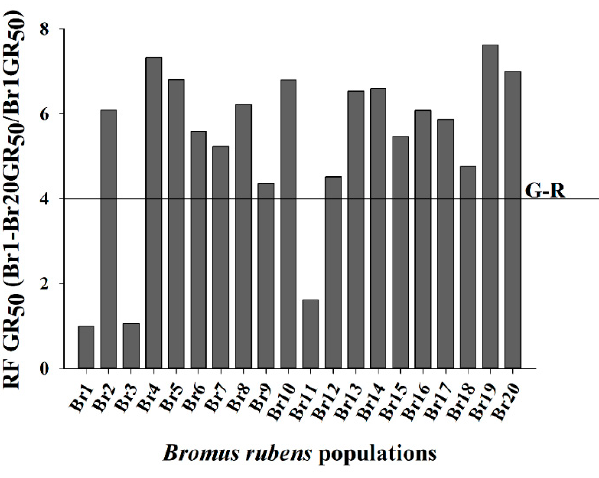
Figure 3. Calculated resistant factor of 20 Bromus rubens populations from Southern Spain. Populations above the line were considered glyphosate-resistant.